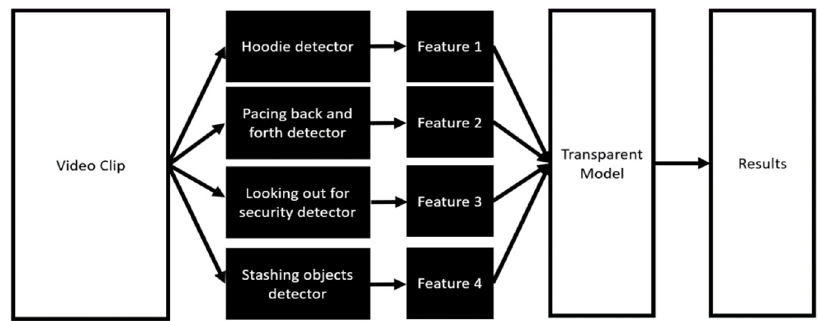
Figure 2. The transparent social signal processing model for shoplifting detection.